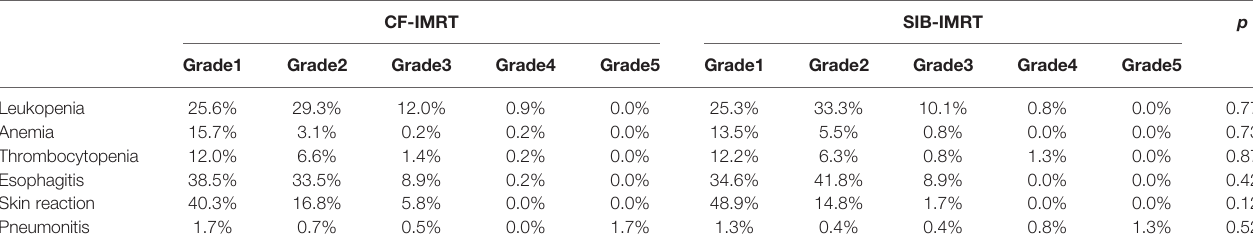
TABLE 2 | Treatment-related toxicities of CF-IMRT and SIB-IMRT groups.